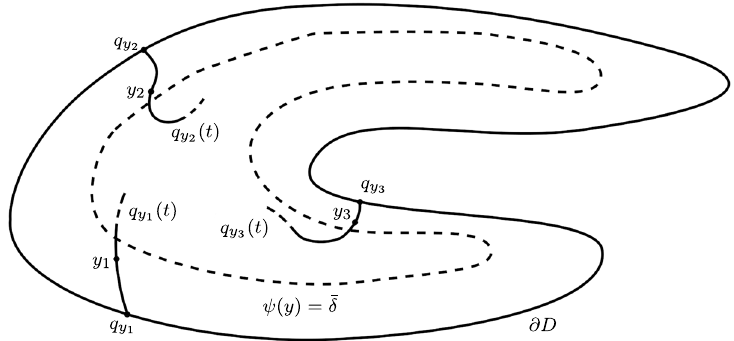
, i 1, 2, 3 = , is such that ψ i